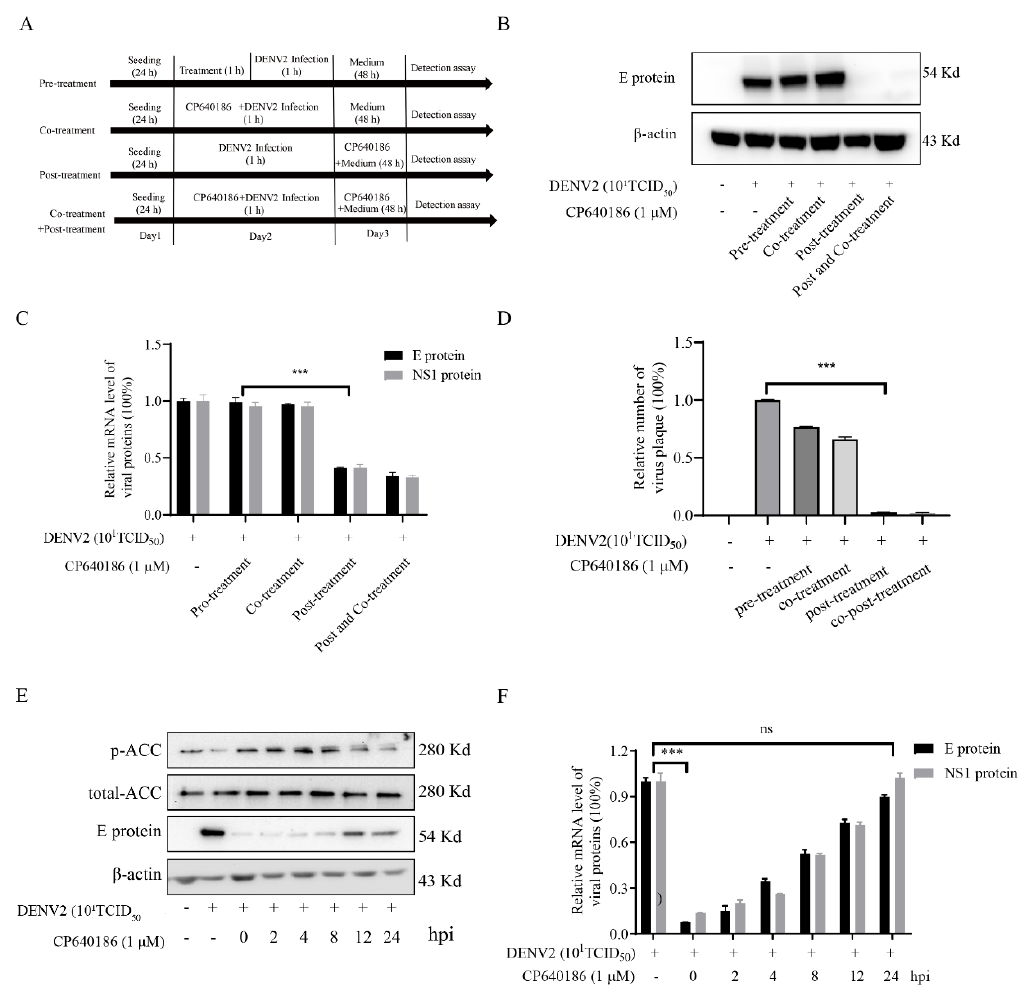
Figure 4. The antiviral model of CP640186. ( A ) The schematic diagram of drug addition of CP640186 with DENV2. ( B ) The viral E protein was analyzed by Western blotting, as shown in ( A ). ( C ) The mRNA levels of viral E protein and NS3 protein were analyzed by RT-qPCR assay, as shown in ( A ). ( D ) The number of progeny viruses in the supernatant was qualified by plaque assay, as shown in ( A ). ( E ) BHK-21 cells were infected with DENV2 at indicated times: 2 h, 4 h, 6 h, 8 h, 12 h, and 24 h. Immediately, the cell culture medium was replaced with a medium containing 1 μM CP640186. Then, the protein levels of p-ACC, T-ACC, and viral E protein were analyzed by Western blotting. ( F ) The mRNA levels of viral E protein and NS3 protein were analyzed by RT-qPCR assay, as shown in ( E ). Each experiment was repeated 3 times and column data represent mean ± SD. *** indicates p < 0.001 .